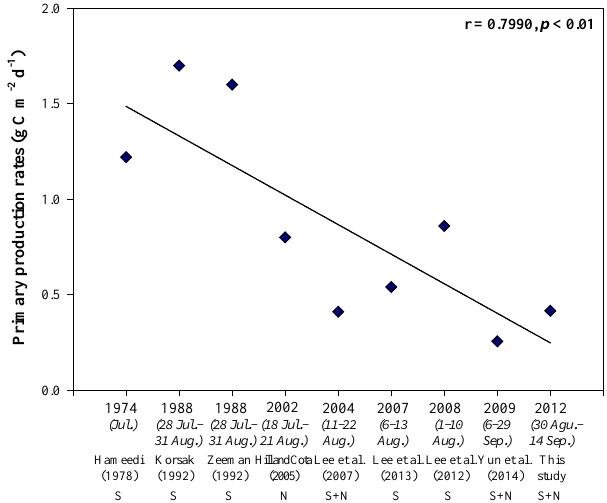
Figure 10. A recent trend of primary production based on in situ carbon uptake measurements ( 13 C or 14 C) in the Chukchi Sea. Study area of each study is indicated by N or S for northern and southern Chukchi Sea,